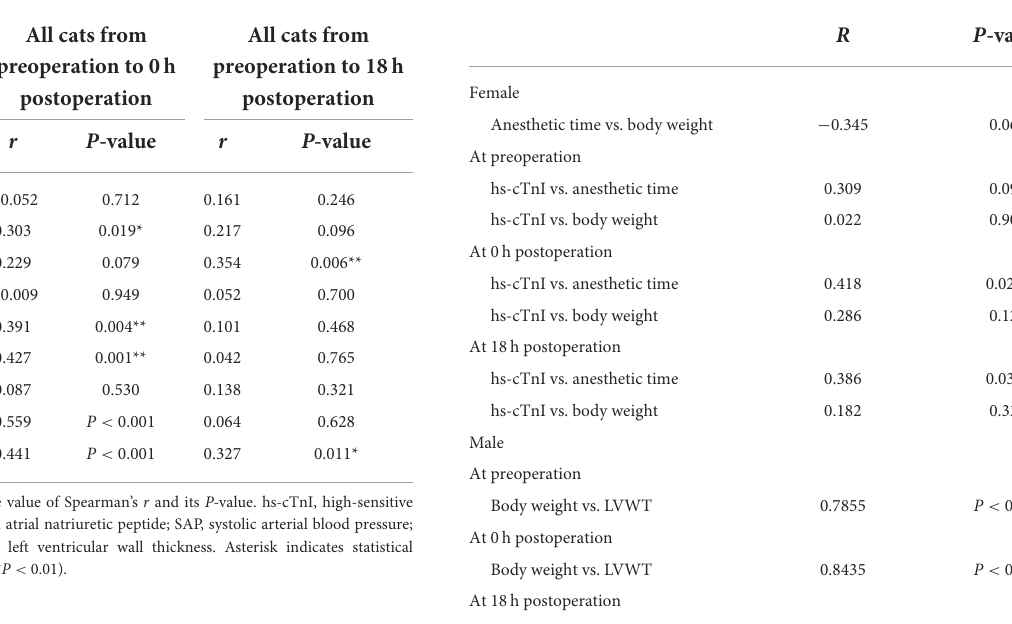
TABLE 5 Correlation coefficients for hs-cTnI, anesthetic time, and body weight in females, and between body weight and LVWT in